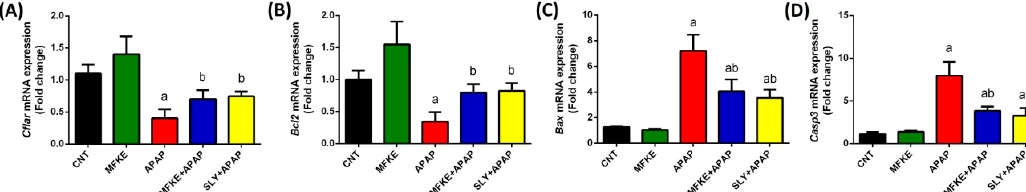
Figure 8. Effects of MFKE on apoptosis related gene expressions in rats treated with APAP-induced liver toxicity. Results are presented as means ± SD of triplicate assays and normalized to Gapdh and expressed as fold change (log2 scale), relative to mRNA levels in controls; a p < 0.05 vs. control rats; b p < 0.05 vs. APAP-treated rats using Tukey’s post hoc test. ( A ) Cellular FLICE (FADD-like IL-1 β -converting enzyme)-inhibitory protein, ( B ) B-cell lymphoma 2, ( C ) BCL2 Associated X, and ( D )